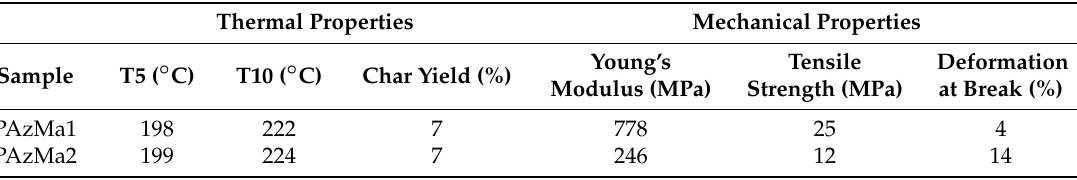
Table 1. Thermal and mechanical properties of films PAzMa1 and PAzMa2. T5 and T10 are temperatures at which 5 and 10% weight loss are observed, respectively.